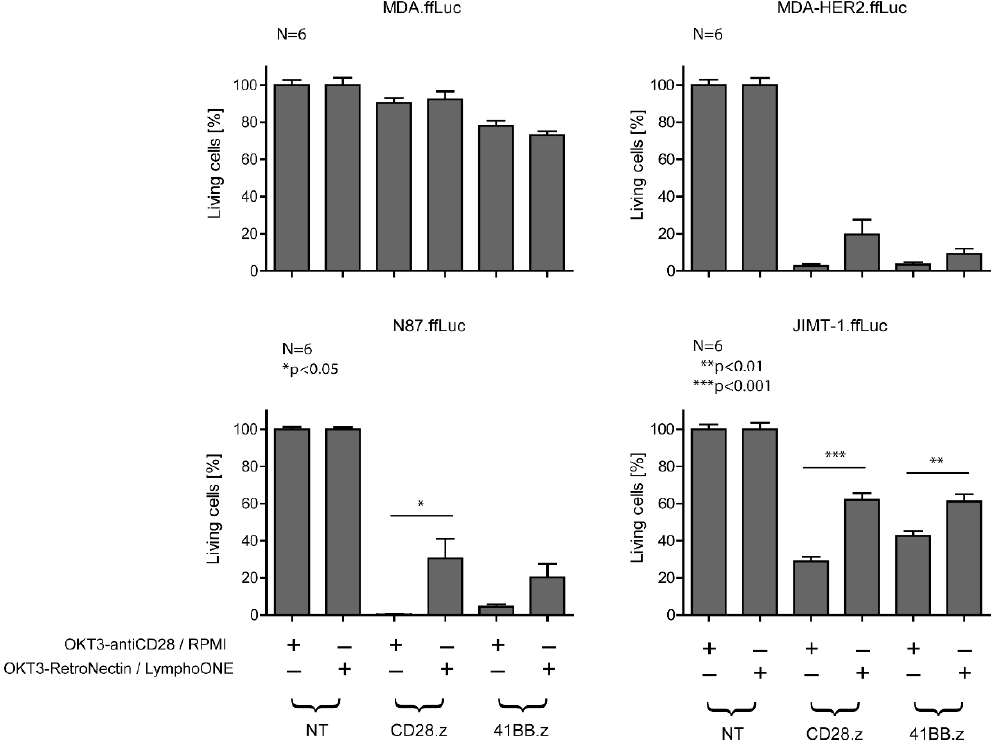
Figure 3. In vitro cytotoxicity of HER2-CAR T cells prepared with the two different stimulation protocols. The cytotoxic activity of CAR T cells was determined by a luciferase-based killing assay. MDA-HER2.ffLuc, N87.ffLuc, and JIMT-1.ffLuc were plated in 96-well flat-bottom plates at a concentration of 10 6 cells/well in duplicates. After 4 h, 10 6 CD28.z and 41BB.z HER2-CAR T cells prepared with the two different stimulation protocols were added. After 24 h, luciferase activity was determined. Empty media, NT T cells, HER2+ target cells cultured without the presence of effector cells, and the MDA.ffLuc cell line served as controls. Histograms represent the mean ± SD ( n = 6, OKT3-antiCD28/RPMI vs. OKT3-RetroNectin/LymphoONE : * p < 0.05, ** p < 0.01, *** p < 0.001).